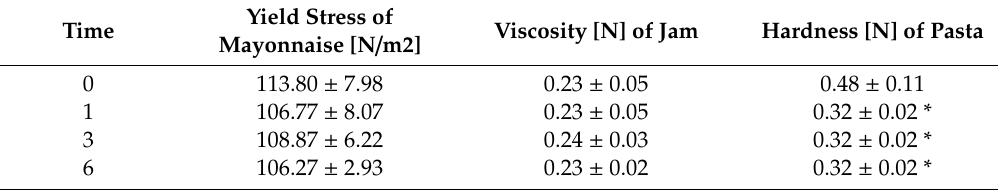
Table 7. Selected texture parameters characterising the food products tested. Yield Stress of Viscosity [N] of Jam Time Mayonnaise [N / m2]